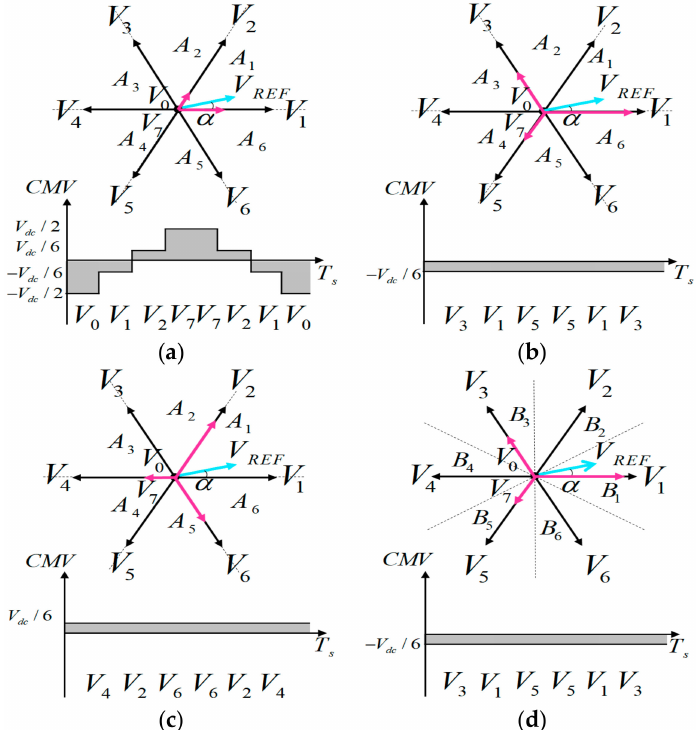
Figure 2. Formation of voltage vectors in the d–q-plane and corresponding common-mode voltage (CMV): ( a ) conventional space vector pulse-width modulation (CSVPWM); ( b ) remote-state pulse-width modulation (RSPWM)1, RSPWM2A; ( c ) RSPWM2B; ( d )